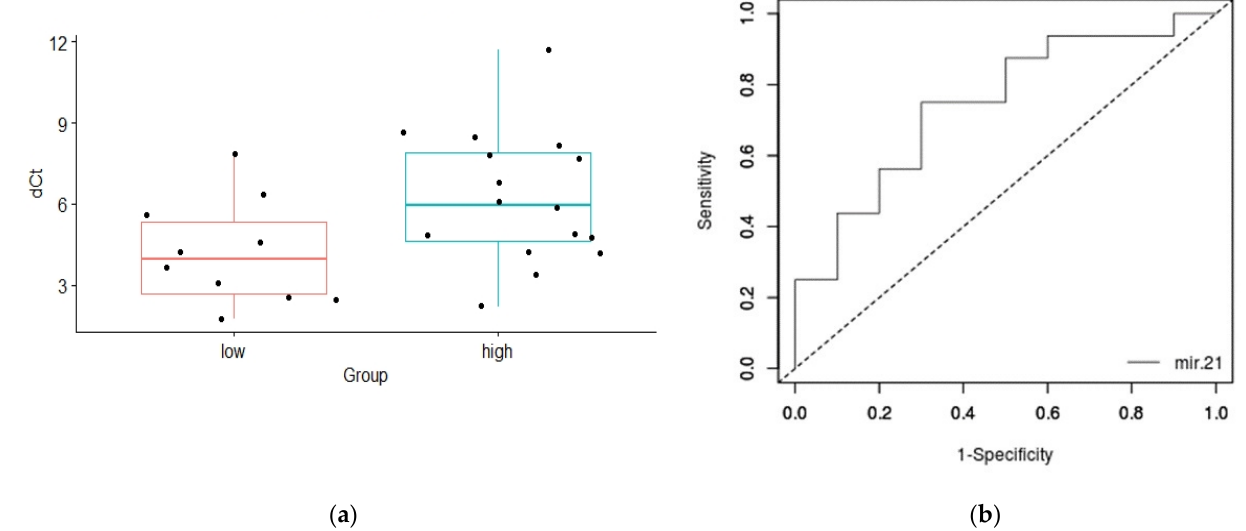
Figure 5. Exosomal mir-21 expression and PCa aggressiveness: ( a ) Difference in the expression levels of exosomal miR-21 between PCa patients with less aggressive and aggressive PCa. Relative miR-21 expression in subgroups was normalized against the spike-in and endogenous controls (dCt, y -axis). Data are shown as interquartile ranges with means ± SD. A Student’s t -test was used to determine statistical significance; ( b ) ROC analysis of exosomal miR-21 was performed to differentiate among PCa patients with less aggressive and aggressive cancer. The corresponding AUC value was 0.74, with p of 0.017. dCt—delta cycle threshold.